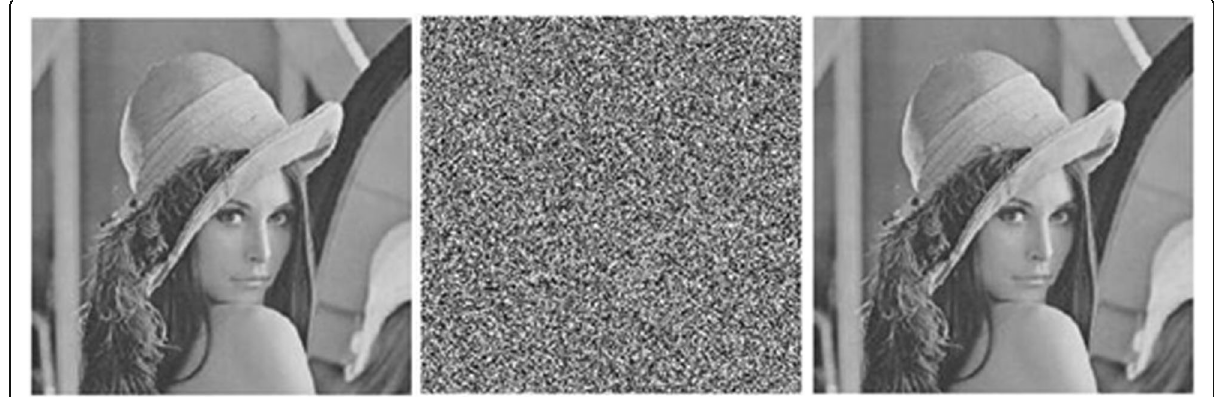
Fig. 6 Encryption and decryption results